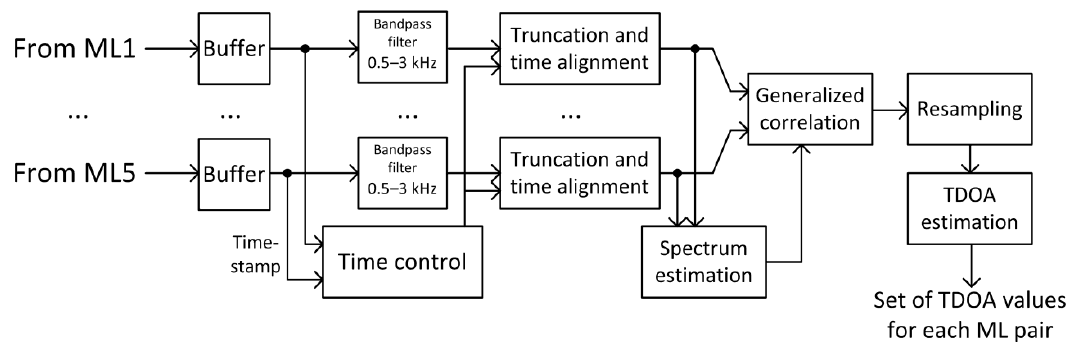
Figure 10. Block diagrams of signal processing in the radio station.